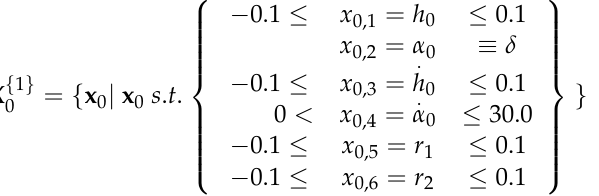
Figure 17. A close-up of Figure 16 which focuses on the airspeed from 12.4 to 13.8 m/s. Random switching between the 2-D LCO and convergence of the system responses can be observed as the initial pitch angle